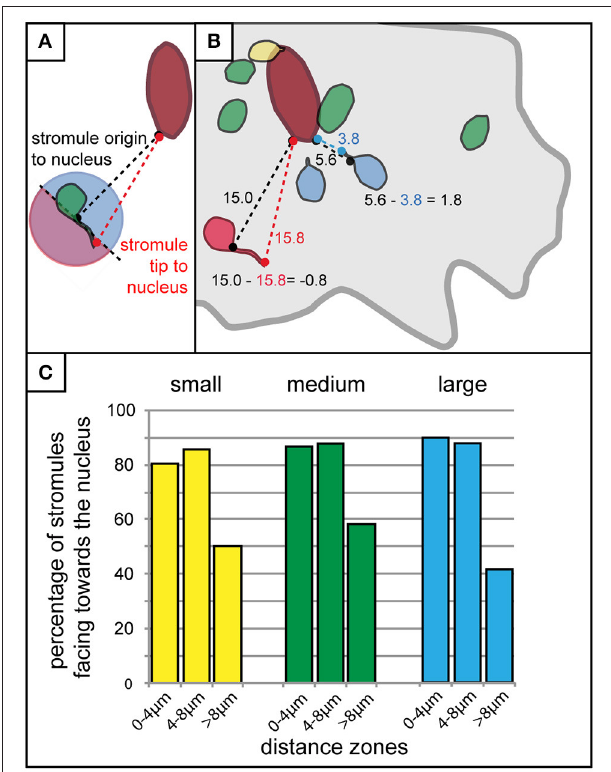
FIGURE 6 | Stromules formed in close proximity to the nucleus usually face it. (A) Schematic outline of the method used for the rough determination of whether a stromule faces toward or away from the nucleus. The distance of the base of the stromule as well as the tip of the stromule to the nucleus were measured and compared. If the stromule tip is further from the nucleus than the base of the stromule (any stromule tip falling within the pink part of the circle for the plastid illustrated here) the stromule would be considered facing away from the nucleus, while any tip that is closer to the nucleus than the base (all those falling within the blue part of the circle) would be considered as facing toward the nucleus. (B) Illustration of example measurements taken from a real cell showing four plastids without stromules (green), one with a stromule and plastid body touching the nucleus (yellow), two that were considered to be facing the nucleus (blue), and one that was considered to be facing away from the nucleus (red). Example calculations for a stromule facing the nucleus (i.e., stromule decreasing the distance between the nucleus and plastid body), and a stromule facing away from the nucleus (i.e., stromule increasing the distance between the nucleus and the plastid body), are outlined in blue and red, respectively. Cell border outlined in gray, nucleus outlined in dark red. (C) Bar chart illustrating the percentage of stromules facing the nucleus (as determined by the criteria outline in A , B ) with increasing distance from the nucleus in small (yellow), medium (green), and large (blue)